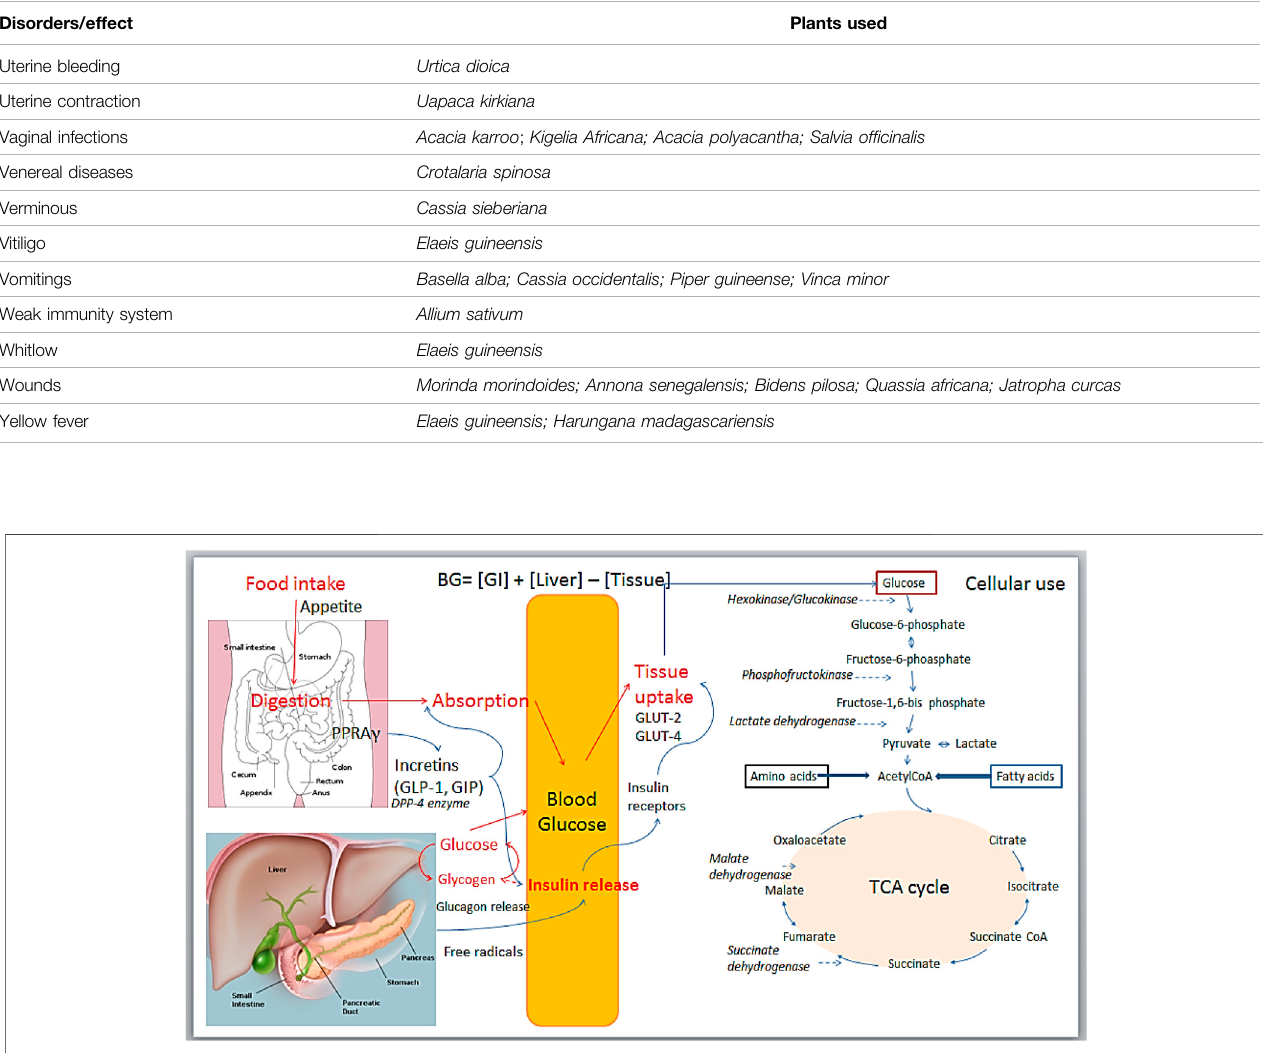
Frontiers in Pharmacology |